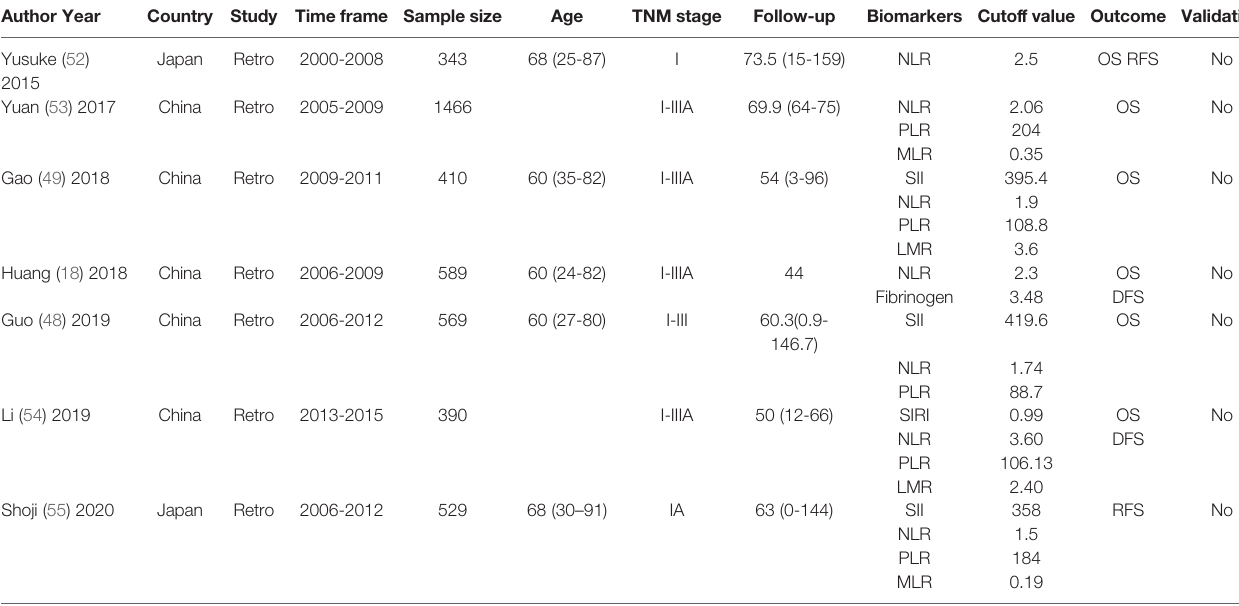
TABLE 5 | Main characteristics of recent eligible studies (operable-stage NSCLC). Country Study Time frame Sample